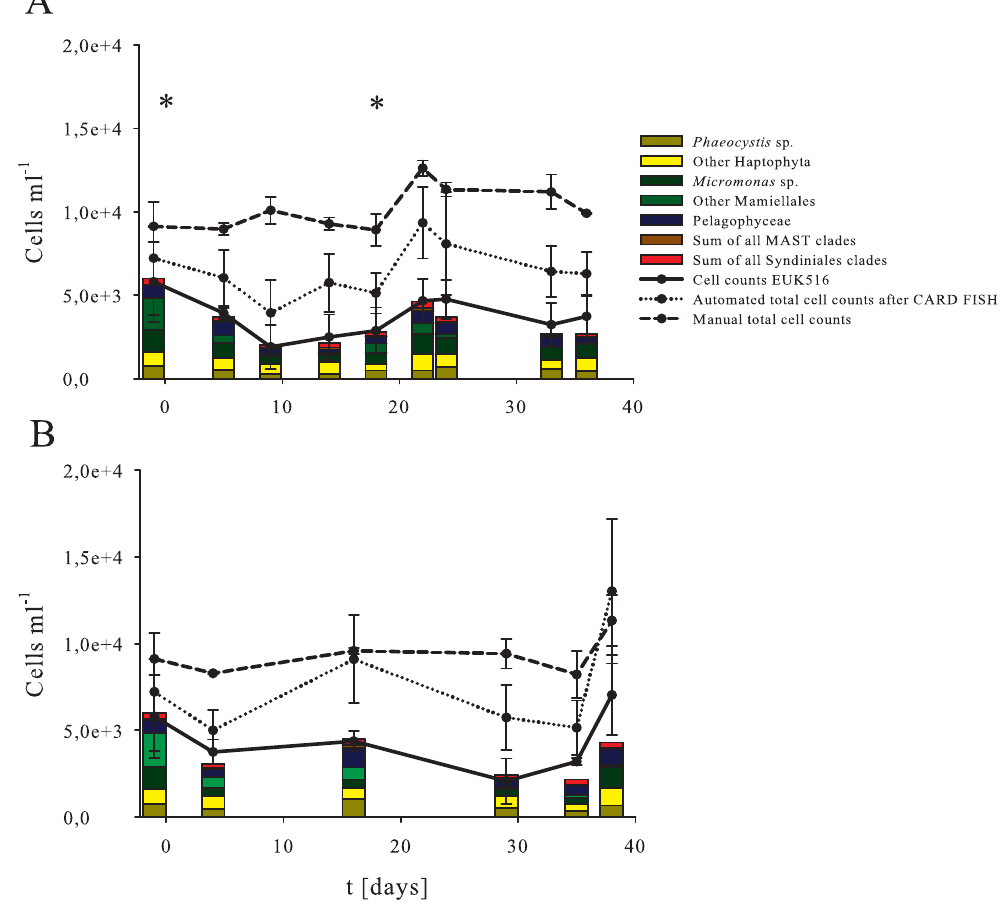
Figure 3. Quantification of the nano- and picoplankton community. Manual total cell counts from Lugol fixed samples (dashed lines), automated total cell counts after CARD-FISH (dotted lines), and cell counts of EUK516 probe (straight line) at IN (A) and OUT (B) stations. Stacked bar charts represent cell numbers of all other probes used in this study. Asterisks mark the iron fertilization events.